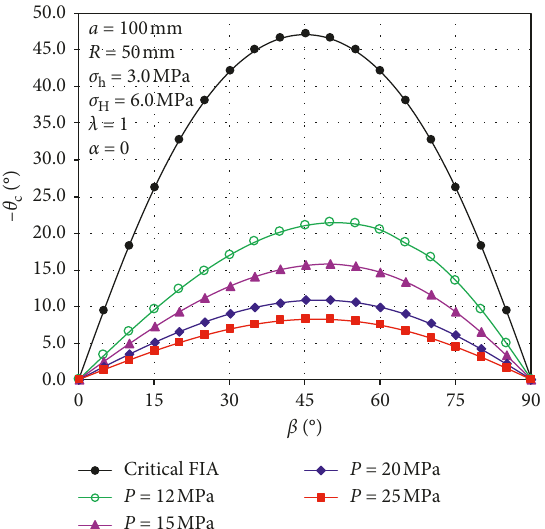
Figure 15: Influence of the high-pressure water injection on the fracture initiation